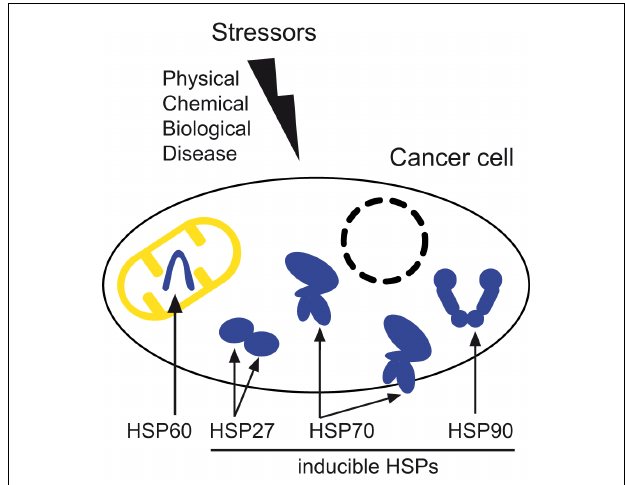
FIGURE 1 | Stressors of physical, chemical, or biological origin, as well as diseases such as cancer can induce the accumulation of heat shock proteins necessary for the survival of cancer cells. This scheme illustrates the main localizations of HSP60, present in the mitochondria, and the three inducible cytosolic/nuclear HSPs: HSP27, HSP70 (also found in the cell membrane), and HSP90.